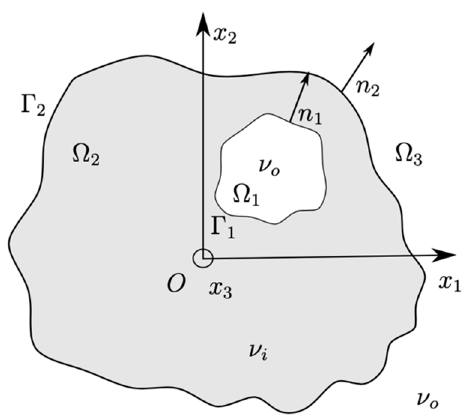
Figure 1. Geometry of a 2D microcavity laser with a piercing hole.